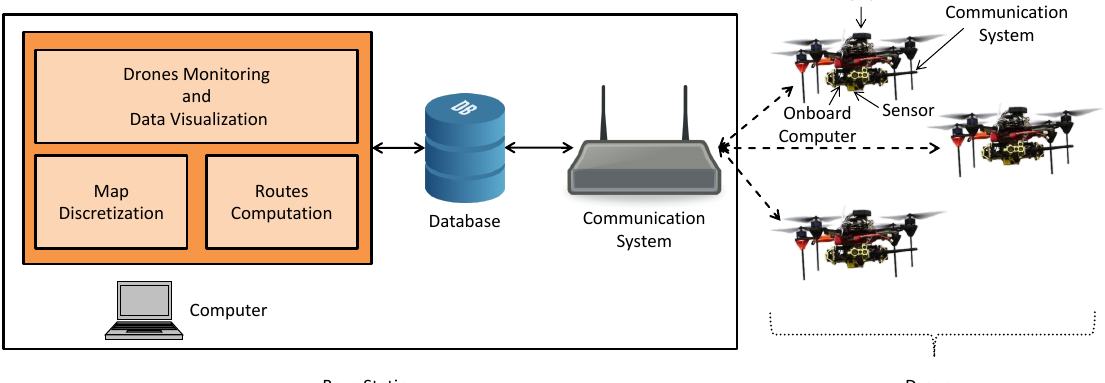
Figure 1. System block